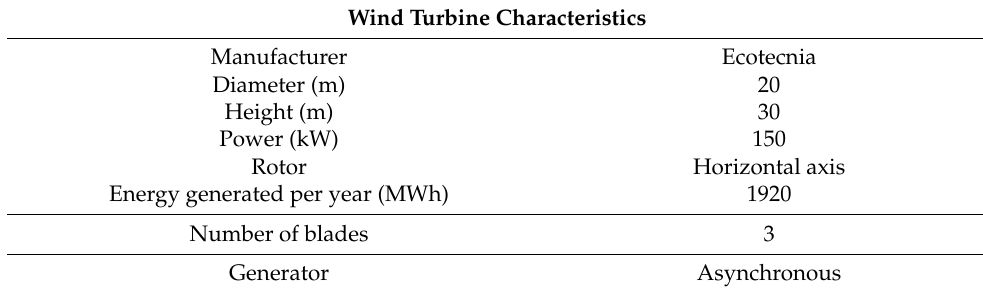
Table 13. Ecotecnia wind turbine data